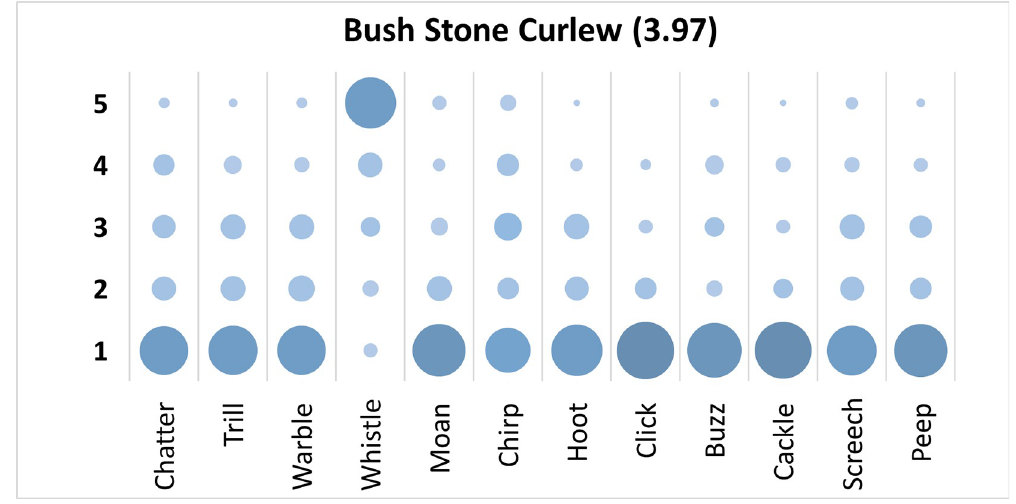
Fig 10. Count of participants’ sound descriptions scores for the Bush Stone Curlew with confidence ratings in brackets.